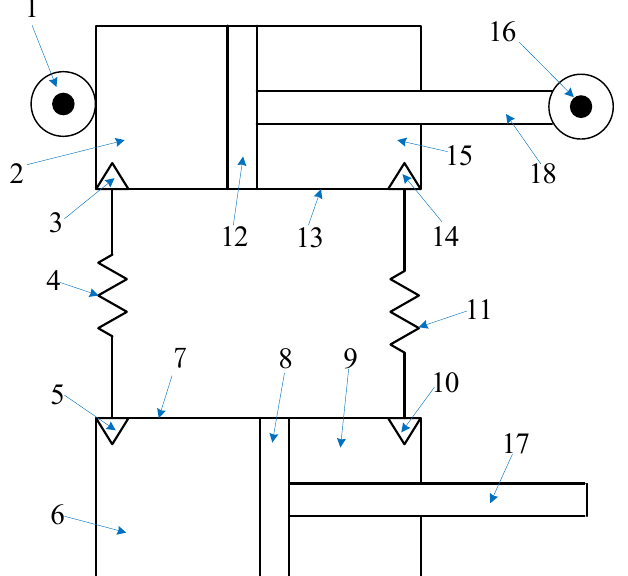
Figure 1. Schematic drawing of dual-cylinder fluid inerter. 1 — terminal; 2 — main chamber; 3 — oil port; 4 — pipeline; 5 — oil port; 6 — main chamber; 7 — cylinder; 8 — piston; 9 — annular chamber; 10 — oil port; 11 — pipeline; 12 — piston; 13 — cylinder; 14 — oil port; 15 — annular chamber; 16 — terminal; 17 — piston rod; 18 — piston rod.